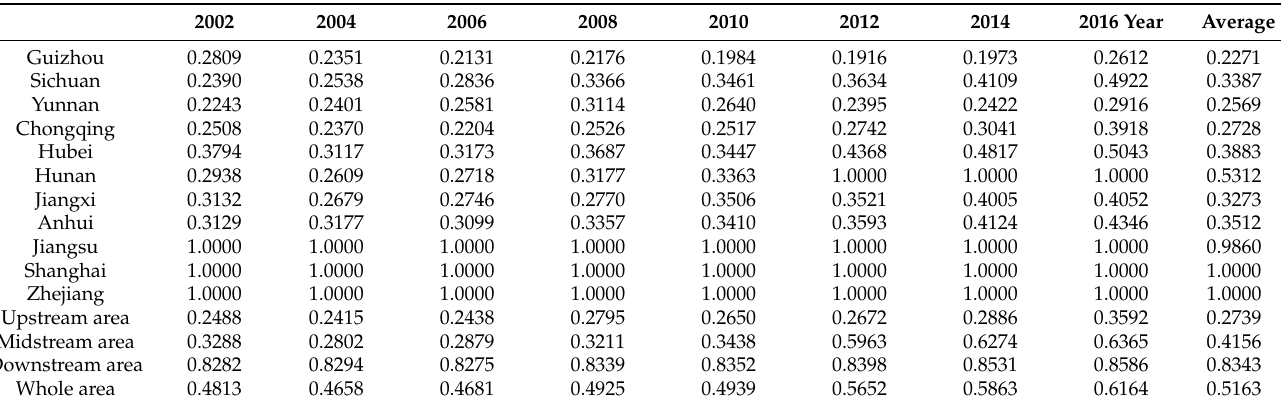
Figure 2. Grey water footprint of the chemical industry in Yangtze River Economic Belt. Table 2. Green development efficiency of the chemical industry in the Yangtze River Economic Belt from 2002 to